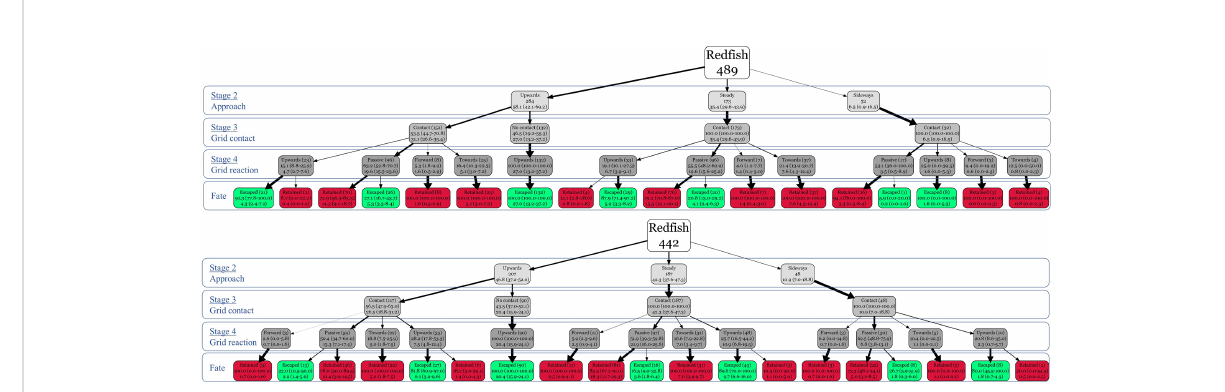
FIGURE 6 Behavioural trees for the 19-mm (top) and 22-mm (bottom) bar spacing Nordmøre grids. White boxes represent the tree root with the number of red fi sh observed, grey boxes represent the behaviors at the different behavioral stages (approach, grid contact, and grid behavior), red boxes represent red fi sh that were retained, and green boxes represent red fi sh that escaped. On each box, the number of red fi sh, conditional probability, and marginal probability, with their respective 95% con fi dence intervals, are shown.